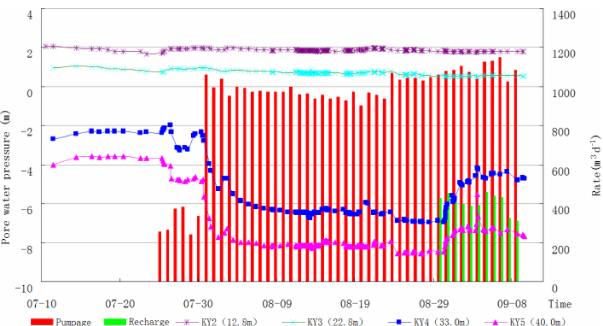
Figure 8. The observation data of land subsidence for the south profile of the foundation pit.